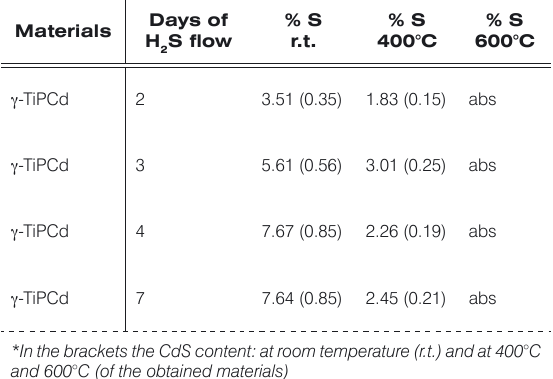
Table 1. Results of microanalysis